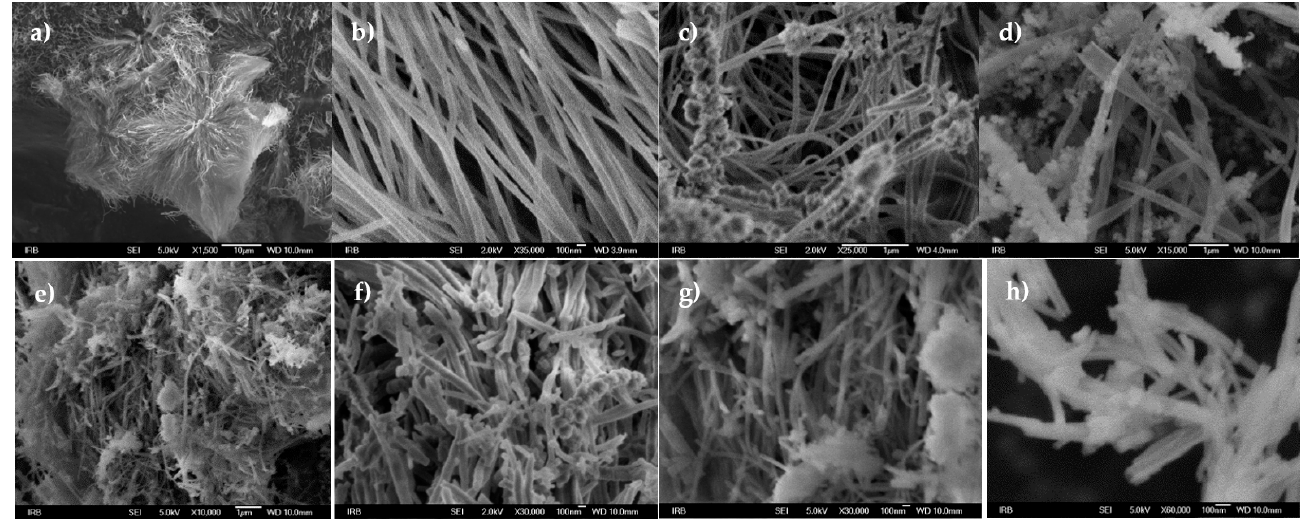
Figure 10. ( a – d ) SEM micrograph of polymer network obtained from 1a /DMF/H 2 O gel after gamma ray radiation; ( e – h ) SEM micrograph of polymer network obtained from 2a /DMF/H 2 O gel after UV rays-radiation.